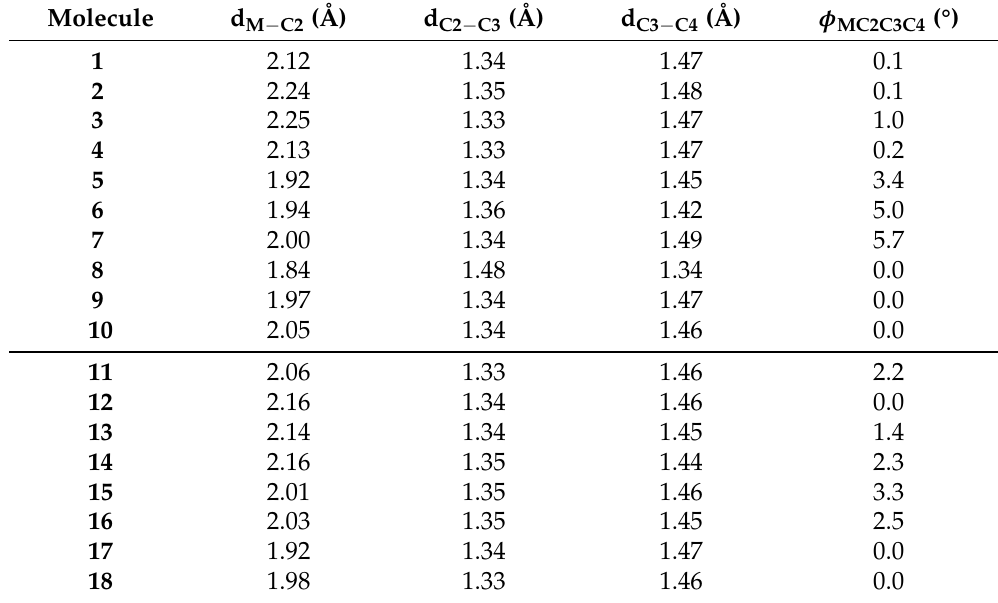
Table 1. Selected geometrical